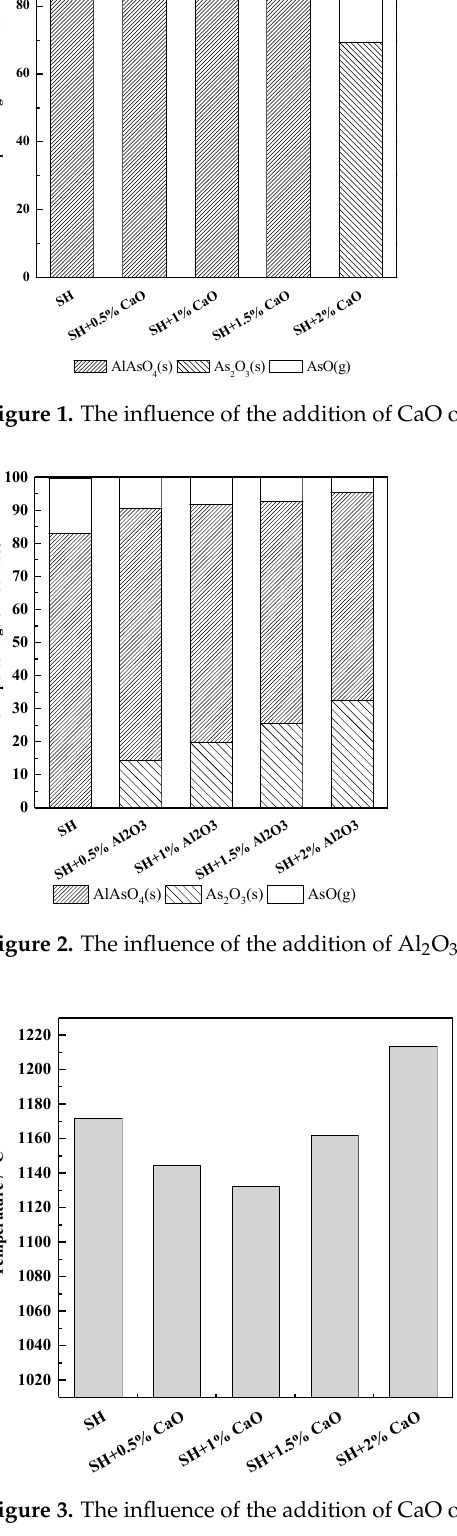
Figure 4. The influence of the addition of Al 2 O 3 on the softening temperature of coal ash. 3.2. Arsenic Volatilization Model During Coal Combustion